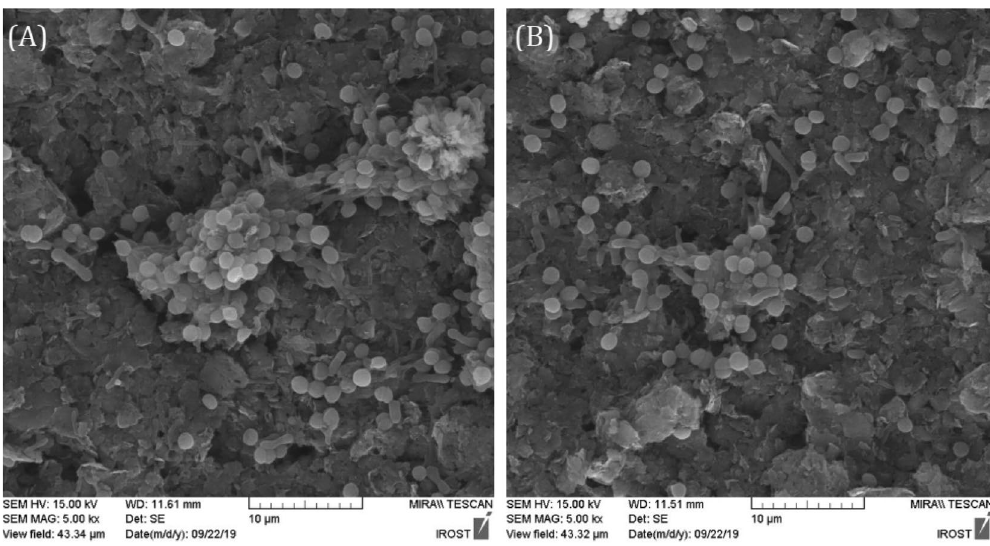
Figure 6. Field emission scanning electron microscopy (FESEM) of Synechocystis biofilm in ( A ) BG-11, and ( B ) BG-11 + NH 4 Cl on the anode surface at 5000